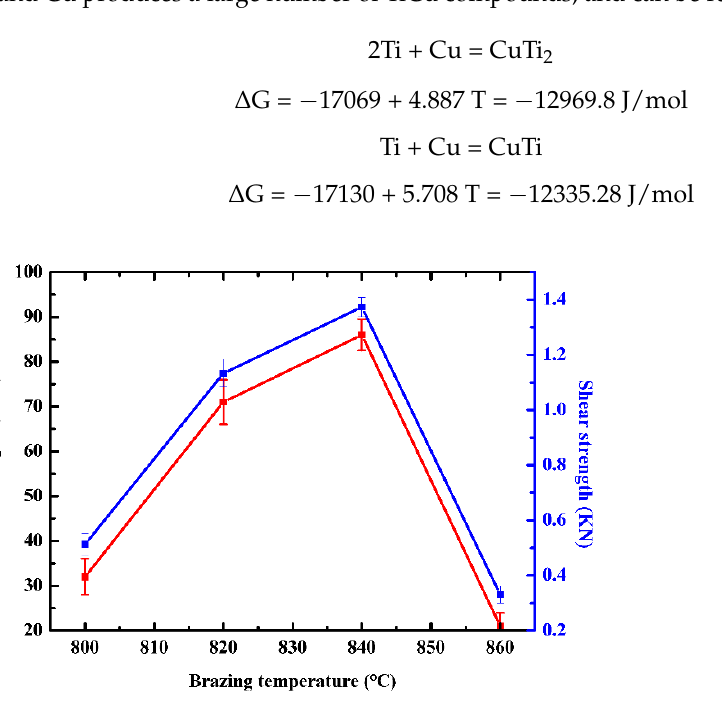
Figure 8. Effect of brazing temperature on the shear strength of TiZrHfNbMo HEAs/Si 3 N 4 joints